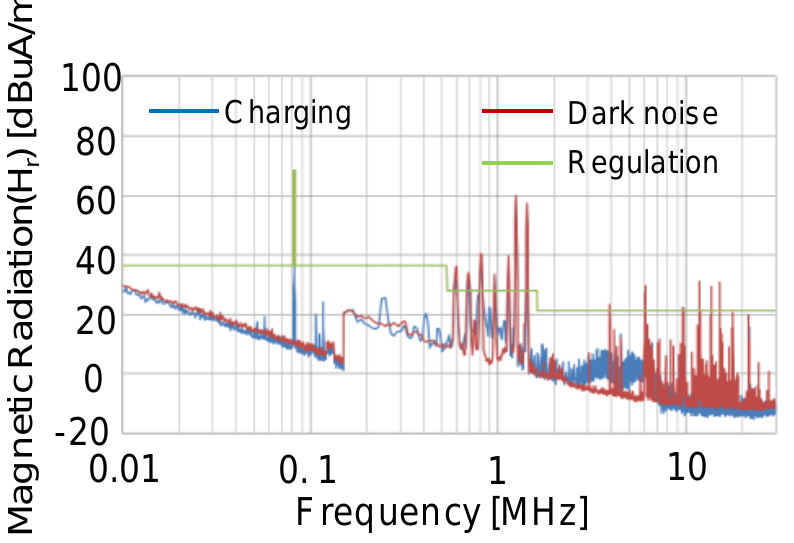
Figure 8. DC charging power and system efficiency of 44 kW wireless charging system with a small bus (WEB3 Advanced).